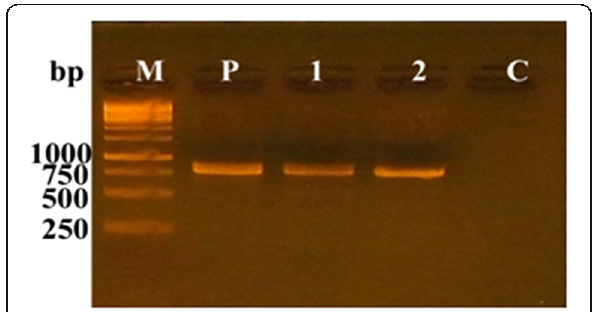
Fig. 2 PCR products amplified of ITS genes from DNA of P: Beauveria bassiana , 1, 2: rice treated with B . bassiana , C: non treated rice, and M: 1 Kbp DNA ladder